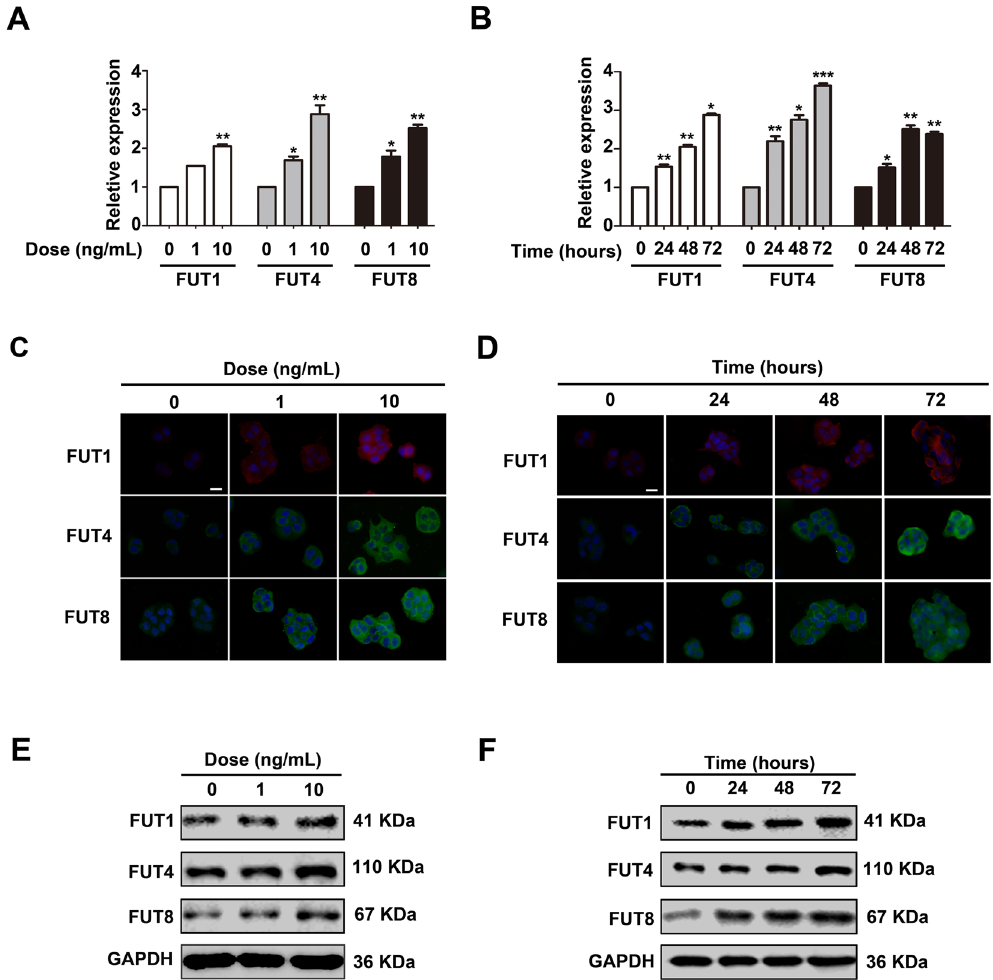
Figure 3. rhPAPPA up-regulates the expression of FUT1, FUT4 and FUT8 in HEC-1A cells. HEC-1A cells were treated with rhPAPPA (1 ng/ml and 10 ng/ml) for 48 h or rhPAPPA (10 ng/ml) for 24 h, 48 h and 72 h, respectively. (A,B) q-PCR detected the mRNA levels of FUT1, FUT4 and FUT8. ( C,D ) Immunofluorescent staining detected the cellular localization and ( E,F ) Western blotting analyzed the protein levels of FUT1, FUT4 and FUT8. GAPDH was used as an internal control. The bar represents 50 μ m. * p < 0.05, ** p < 0.01, *** p < 0.001. The data were presented as the means ± SEM of three independent rhPAPPA increases the expression of FUT1,FUT4 and FUT8 in HEC-1A cells. Different subtypes of N-fucosylation were catalyzed by specific FUTs. Based on the results above, we sought to explore whether rhPAPPA could increase FUT1, FUT4 and FUT8 expression. HEC-1A cells were treated with different doses of rhPAPPA (1 ng/ml, 10 ng/ml) for 48 h, or rhPAPPA (10 ng/ml) for 24 h, 48 h and 72 h. RNA and total protein were collected. The results of q-PCR (Fig. 3A and B), immunofluorescent staining (Fig. 3C and D) and Western blotting (Fig. 3E and F) showed that rhPAPPA up-regulated the mRNA and protein expression levels of FUT1, FUT4 and FUT8. rhPAPPA rescues the impaired endometrium receptivity through up-regulating the specific N-fucosylation level. To explore the roles of specific FUTs in regulating endometrium receptivity, FUT1, FUT4, or FUT8 siRNAs were transiently transfected into Ishikawa cells to knockdown their expression, respec- tively. We found that rhPAPPA recovered the reduced FUT1, FUT4 and FUT8 expression to the level nearly similar to scrambled siRNA treated cells (Fig. 4A). Moreover, Lectin blotting (Fig. 4B) and Lectin flourescent staining (Fig. 4C) results also displayed that the reduced α 1,2-, α 1,3- and α 1,6-fucosylation levels were restored by rhPAPPA. The adhesive statistics results showed that each FUT siRNA transfection impaired Ishikawa cell receptivity, while rhPAPPA partially rescued the receptivity. However, after incubation with UEA-1, LTL or LCA, respectively, the rescued receptivity was decreased (Fig. 4D). These results suggest that rhPAPPA rescues the impaired receptivity through up-regulating the specific N-fucosylation level. rhPAPPA up-regulates the expression of FUT1, FUT4 and FUT8 via IGF-1R/PI3K/Akt signaling pathway. To explore whether PAPPA could activate the IGF-1R/PI3K/Akt signaling pathway, Ishikawa cells were treated with different doses of rhPAPPA (1 ng/ml, 10 ng/ml). The results showed that the expression level of